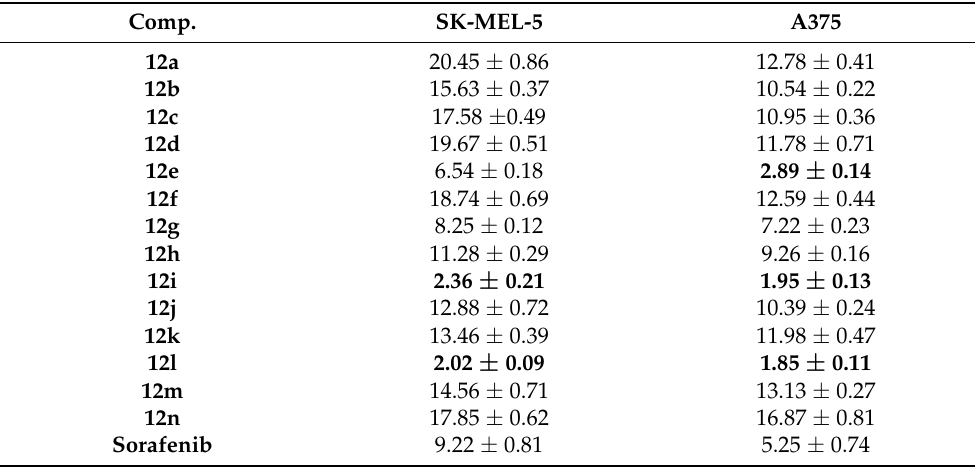
Table 4. IC 50 ( µ M) 1 of the target compounds 12a–n over SK-MEL-5 and A375 cell lines.